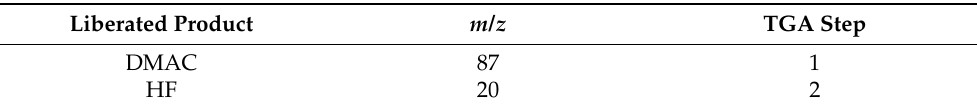
Table 4. Mass Spectrometry (MS) data of the 30-min wet mixture with N , N -dimethylacetamide (DMAC) as solvent and dried at 130 ◦ C for 12